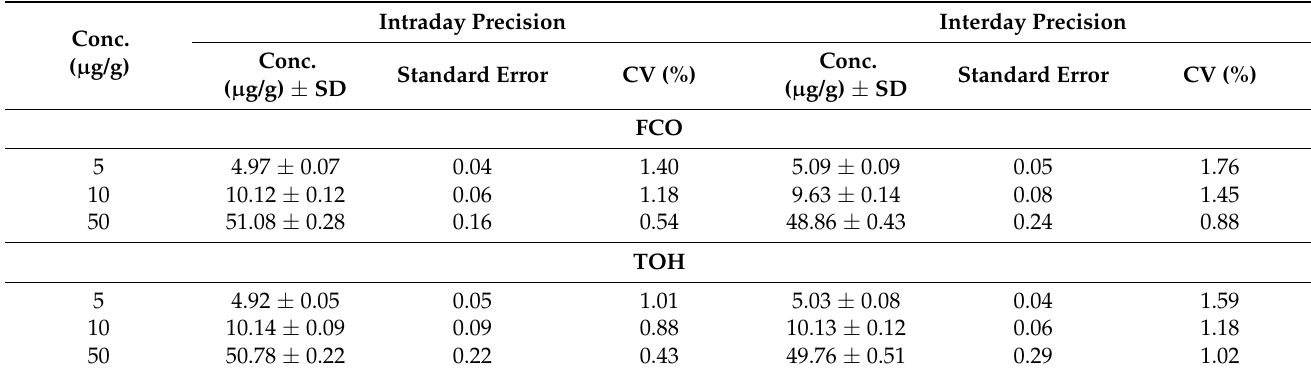
Table 3. Determination of intra/interday precision of FCO and TOH for GC-MS approach (mean ± SD; n = 3).